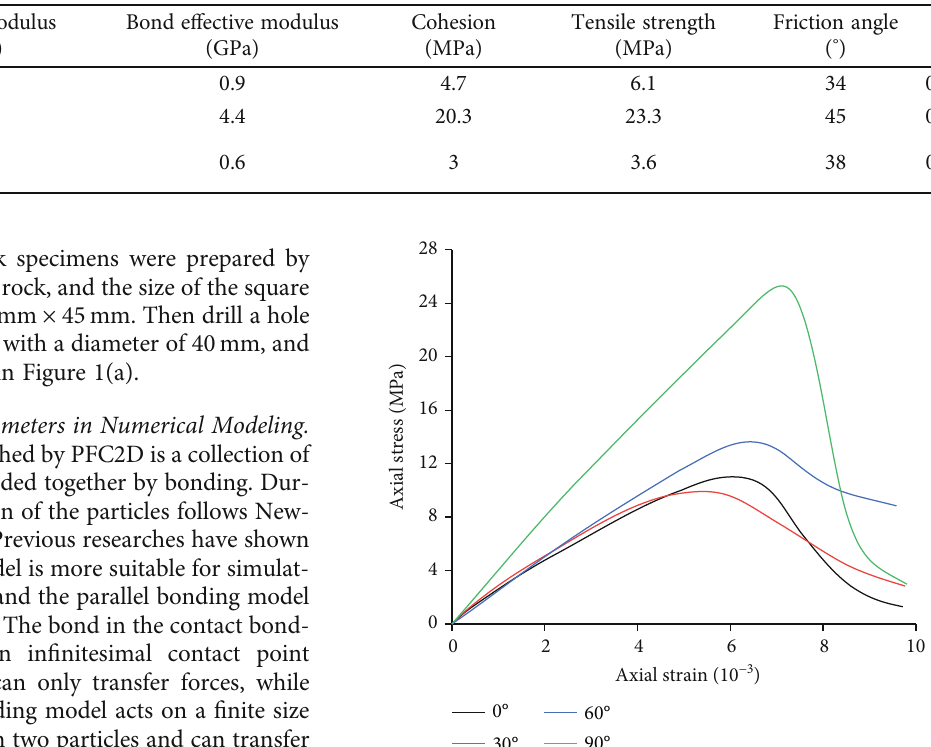
Table 2: Microparameters used in PFC for complicated rock strata.